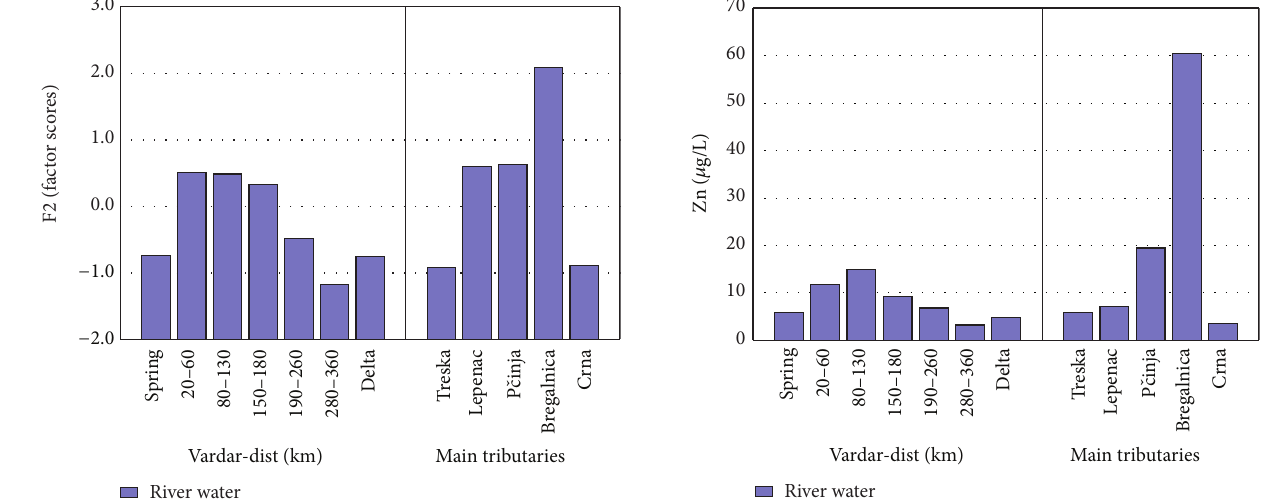
Figure 6: Concentration of Zn found in river Vardar and main